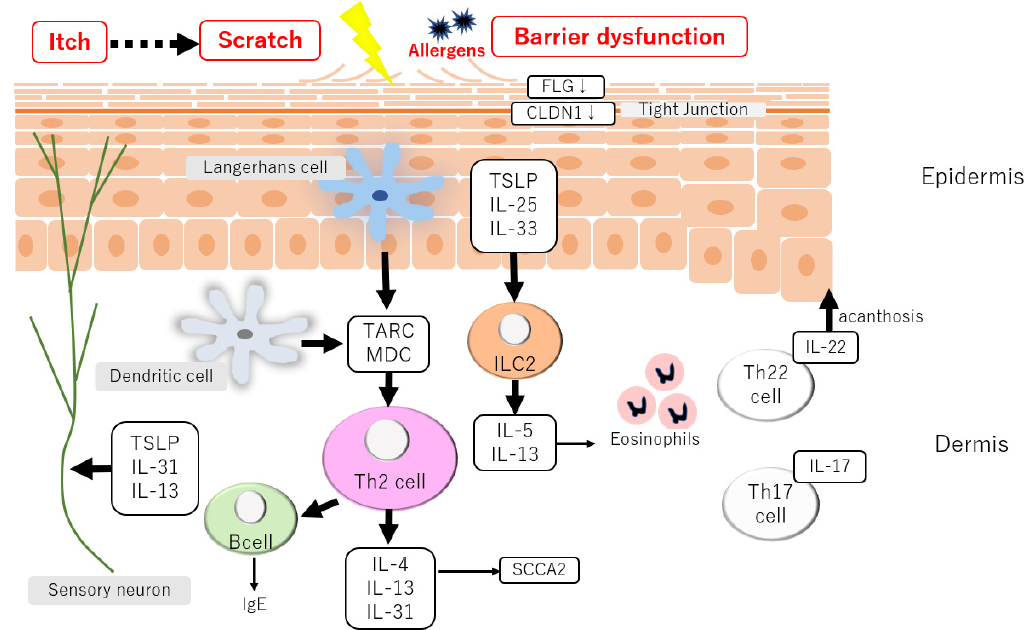
Figure 1. Pathogenesis of atopic dermatitis. Skin barrier dysfunction is a trigger for skin inflamma- tion in AD. The following Th2 chemokines and cytokines production establishes the chronic inflam- mation in the skin recognized as the characteristics of clinical manifestation of AD.